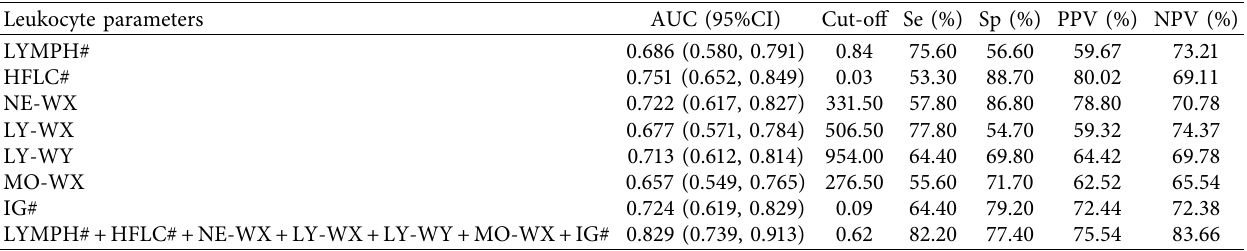
Table 4: Efcacy evaluation of leukocyte parameters in diferential diagnosis between sepsis and nonseptic infection.